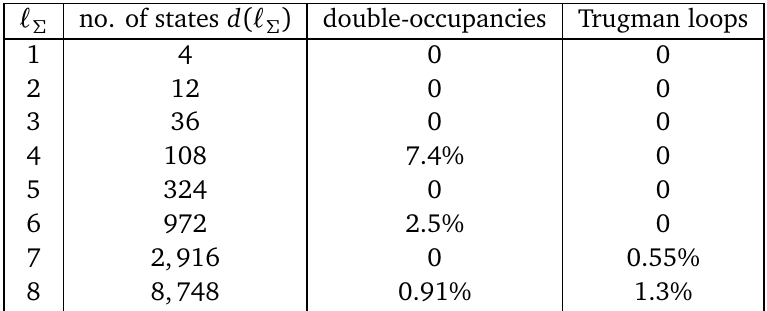
Table 1: Imperfections of the string model. The string basis with two distinguish- able holes includes states | x , Σ 〉 corresponding to unphysical double-occupancies of 1 holes in the associated microscopic states | Ψ ( x , Σ ) 〉 . Their relative fraction of all 1 string states N ( ℓ Σ ) of a given length ℓ Σ is indicated. The relative number of Trug- man loop configurations [ 13 ] is also